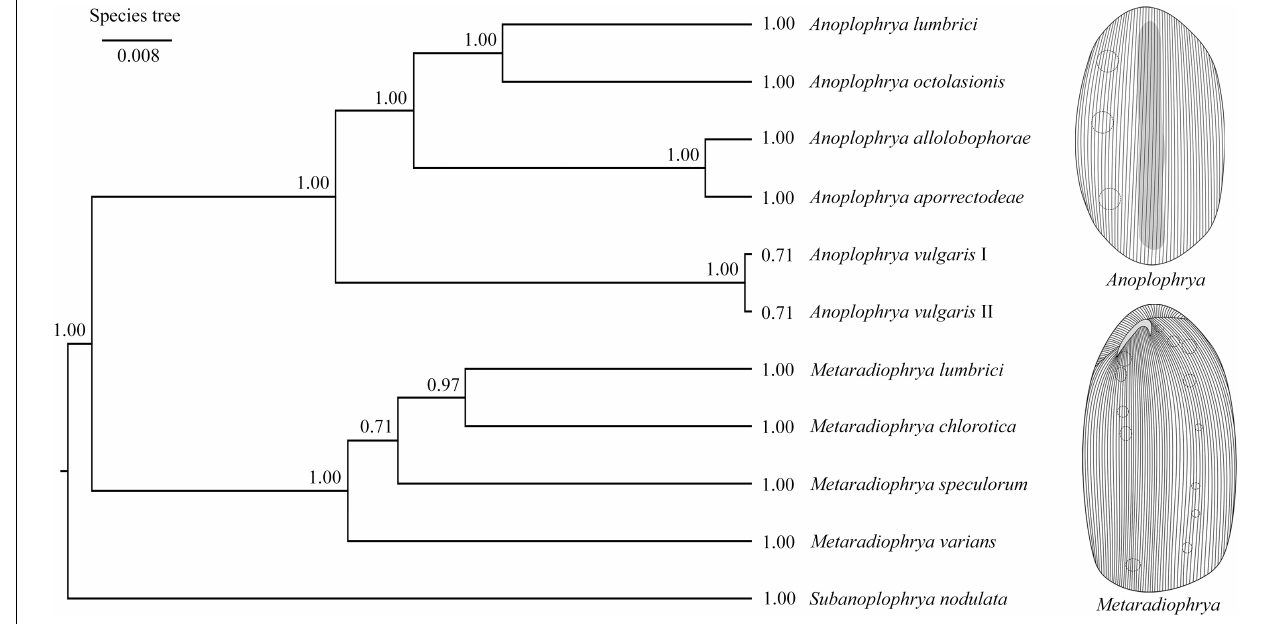
FIGURE 3 | Coalescent species tree based on 16S, 18S, 28S rRNA, and ITS region sequences of astome ciliates isolated from lumbricid earthworms. Posterior probabilities of clades are provided along internal branches and posterior probabilities for the presence of individual species are provided behind the terminal branches. Scale bars denote the fraction of substitutions per site.